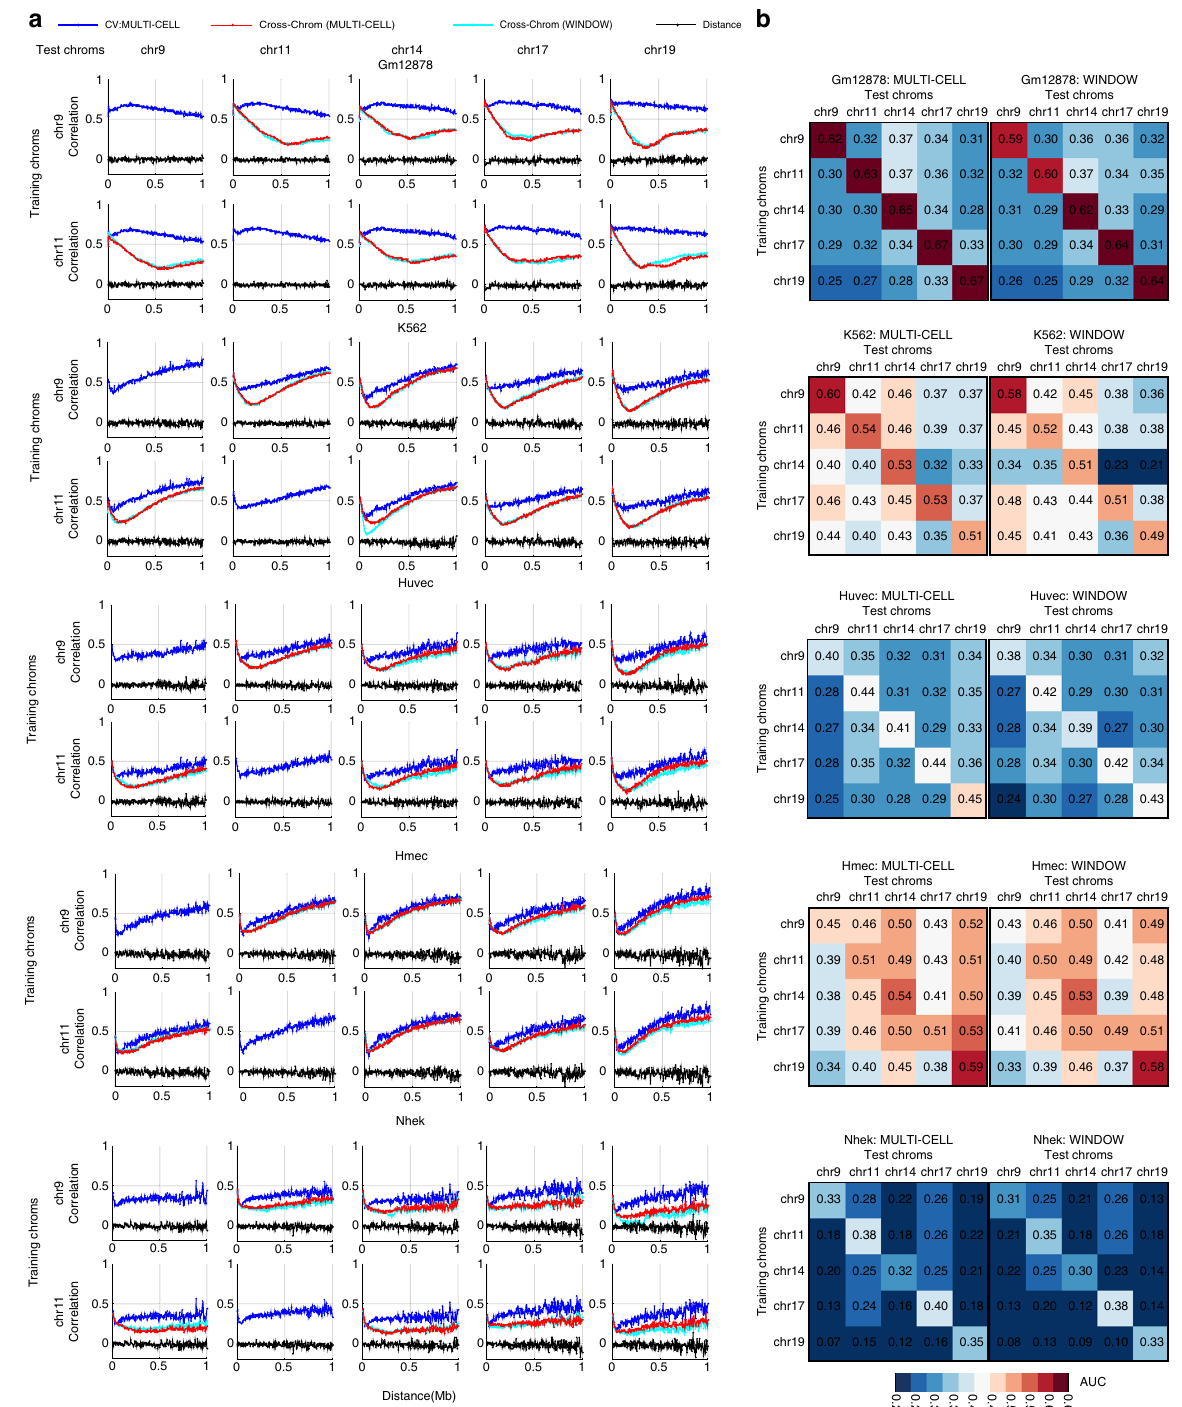
Fig. 3 HiC-Reg cross-chromosome performance. a The distance-strati fi ed Pearson ’ s correlation plot when training on one chromosome and testing on a different chromosome from the same cell line. Shown are the distance-strati fi ed correlations for models trained on chromosome 9 and 11 (row groups) and tested on chromosome 9, 11, 14, 17, 19 (columns) at 5 kb resolution in different cell lines. Each pair of rows corresponds to a particular cell line and results are shown for fi ve cell lines: Gm12878, K562, Huvec, Hmec, Nhek. The blue line refers to training and testing on the same chromosome in cross-validation mode. b Heatmap of AUC for all pairs of tested cross-chromosome experiments. Each off-diagonal entry in the heatmap denotes the AUC when trained on the row chromosome and tested on the column chromosome. The more red an entry the better the performance in that chromosome pair combination. The diagonal entries are the AUC values when training and testing on the same chromosome in cross-validation mode. Source data are provided as a Source Data fi